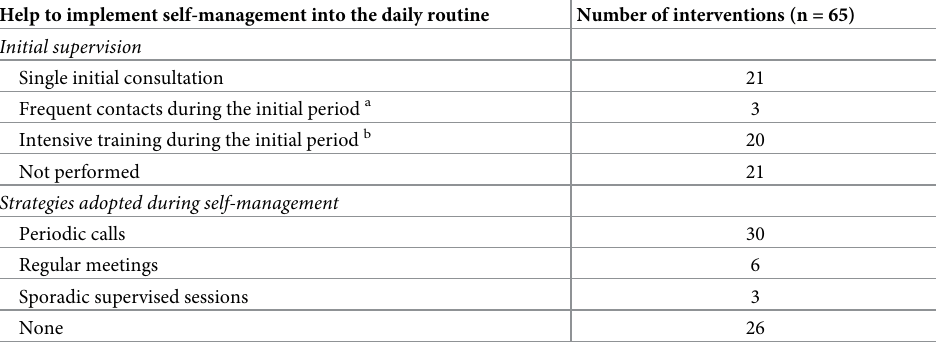
a Frequent contact during the initial period included studies where authors repeatedly checked for patients’ adherence and comfort after the prescribed exercises via weekly in-person meetings, phone calls and emails. b Intensive training during the initial period involved studies in which authors provided a supervised period at the beginning of the program in order to educate patients and improve their long-term adherence.